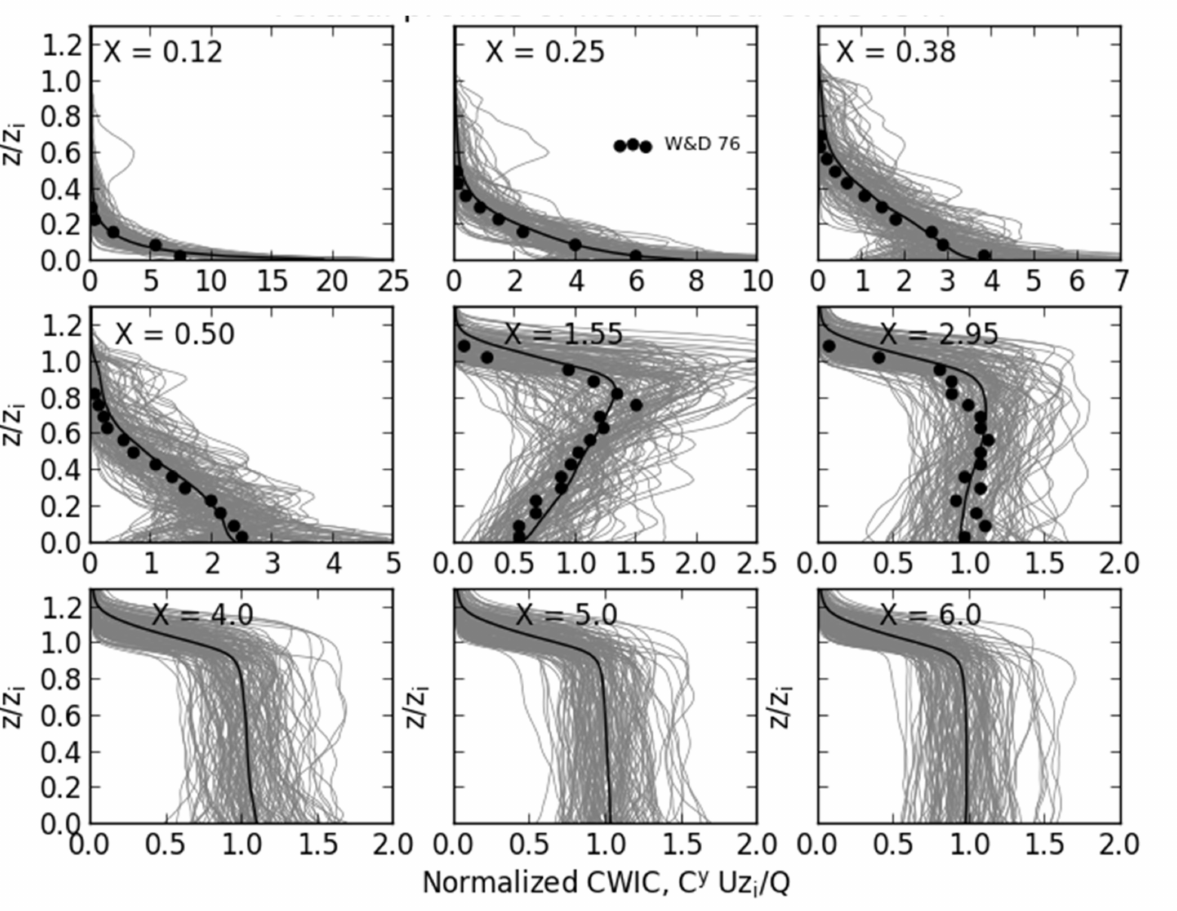
Figure 5. Crosswind integrated vertical dispersion as a function of the downwind distance from the release location, for the Willis and Deardorff [35] water tank experiments. The gray lines depict 130 realizations from the JOLES model, and the black lines show the average of these realizations. The circles represent data measured by Willis and